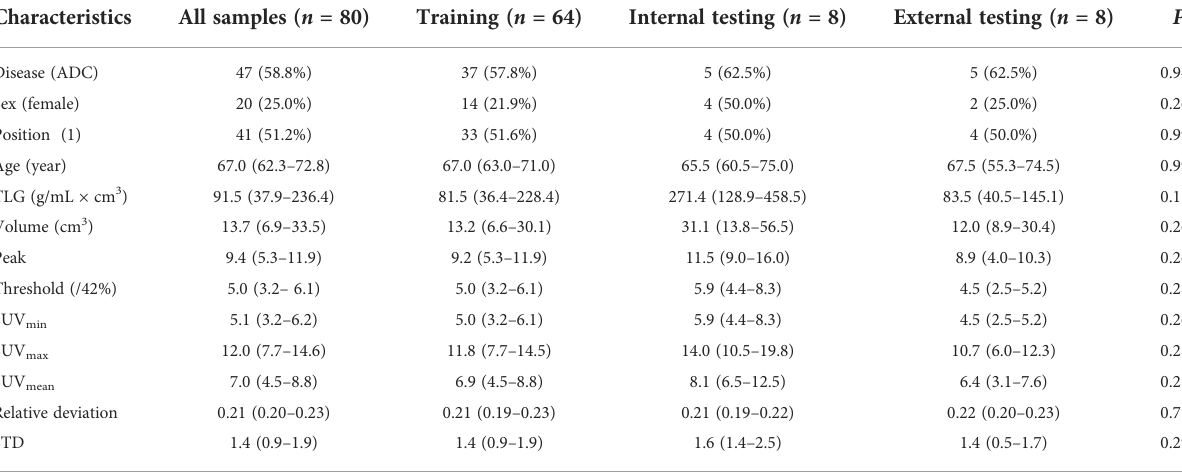
TABLE 1 Clinical characteristics in the study sample ( n = 80; current thresh: